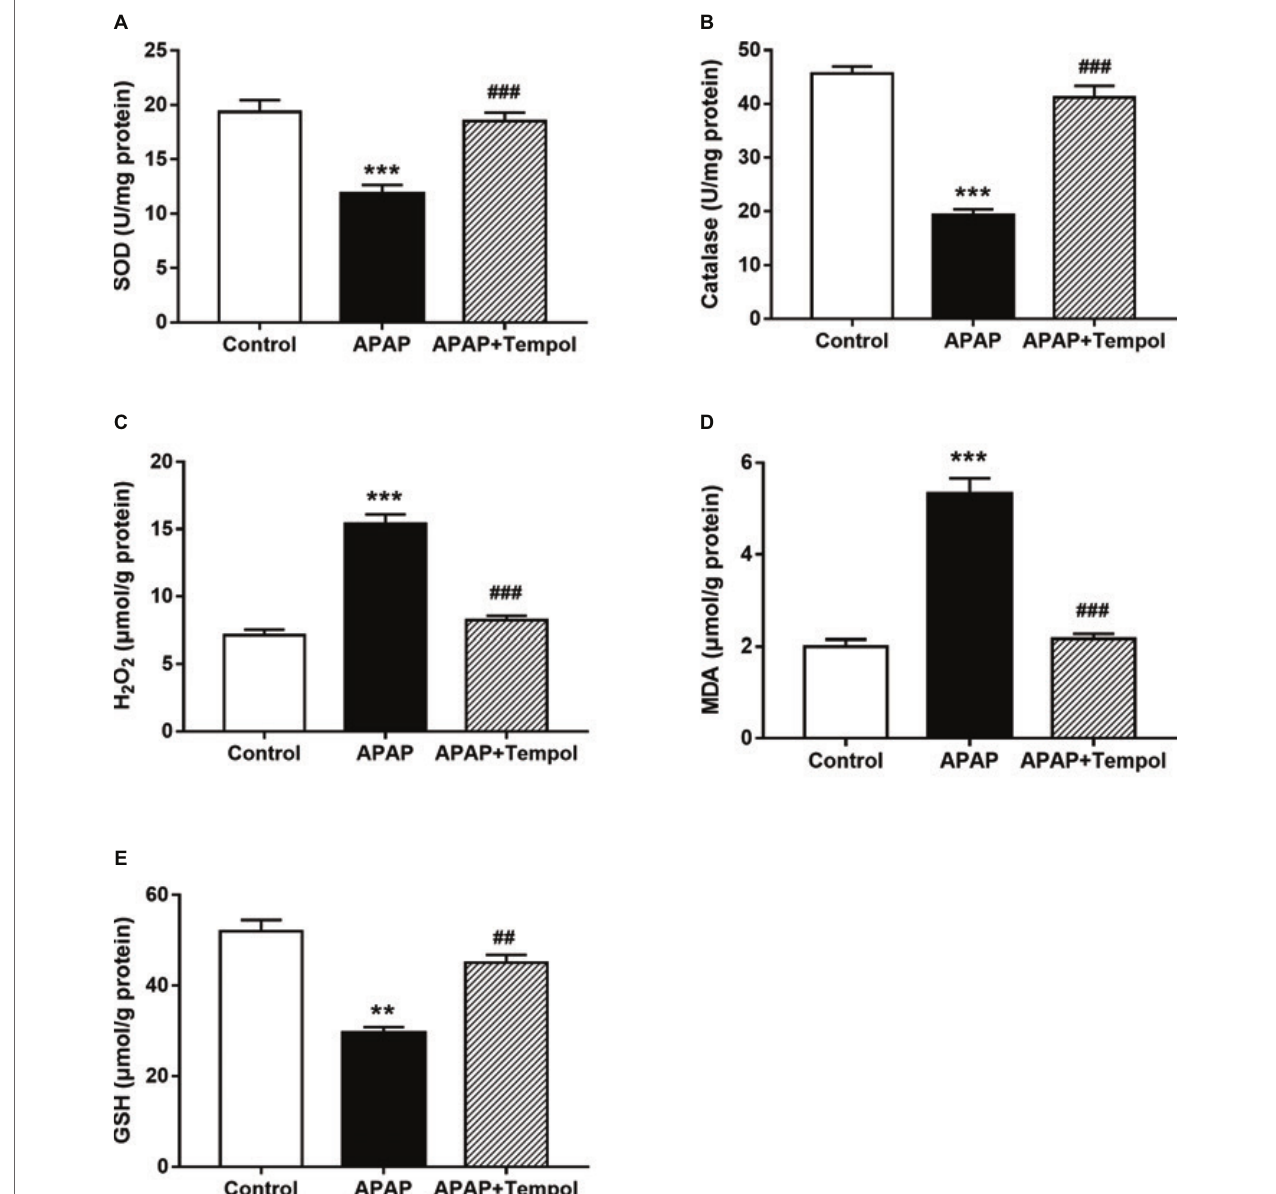
FIGURE 2 | Tempol treatment inhibits oxidative stress in acetaminophen-induced acute hepatotoxicity. (A) Levels of SOD in liver from the control mice (control), vehicle-treated hepatotoxicity mice (APAP), and tempol-treated hepatotoxicity mice (APAP + tempol). (B) Levels of catalase in liver from three groups. (C) Levels of H 2 O 2 in liver from three groups. (D) Levels of MDA in liver from three groups. (E) Levels of GSH in liver from three groups. Data are mean ± SEM. ** p < 0.01 vs. control, ## p < 0.01 vs. APAP, *** p < 0.001 vs. control, ### p < 0.001 vs. APAP, n =